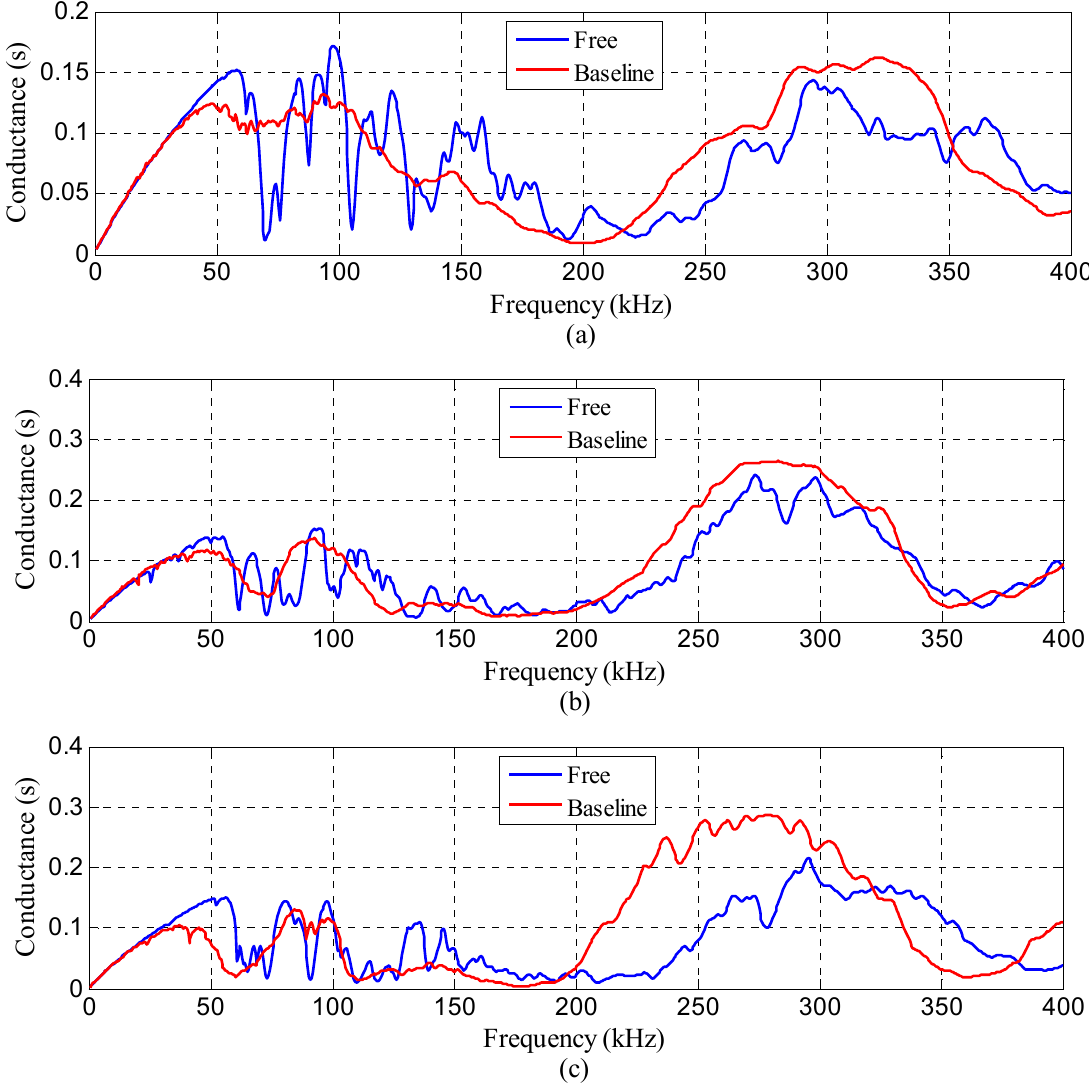
Figure 6. Conductance spectra between free condition and baseline condition of the three SAs in specimen S1. ( a ) SA-1, ( b ) SA-2, ( c ) SA-3.